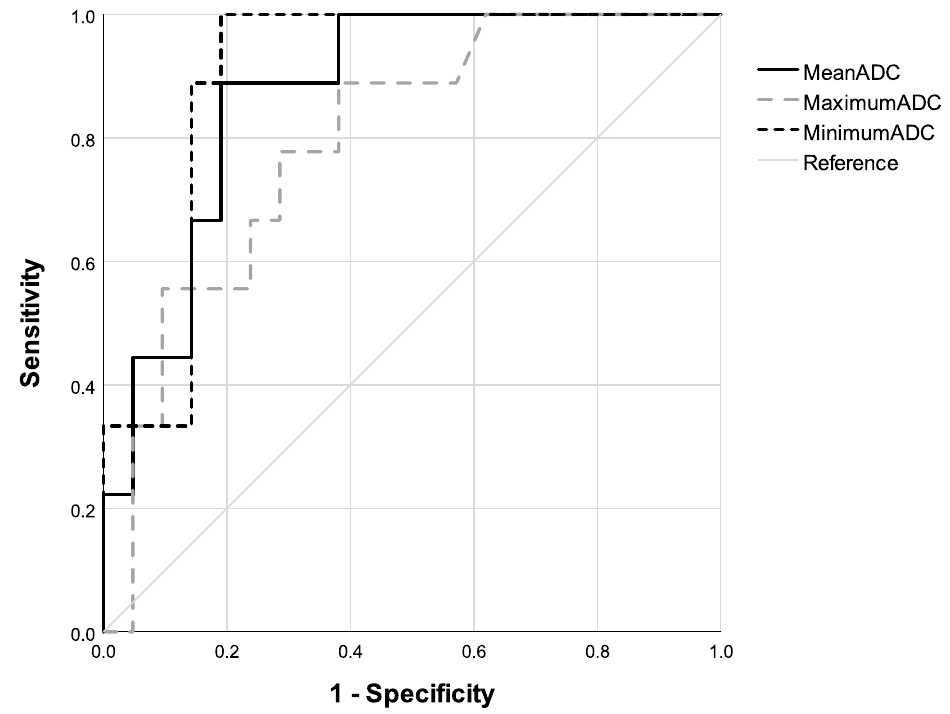
Figure 2. ROC curves for ADC values differentiating aggressive chordoma from stable